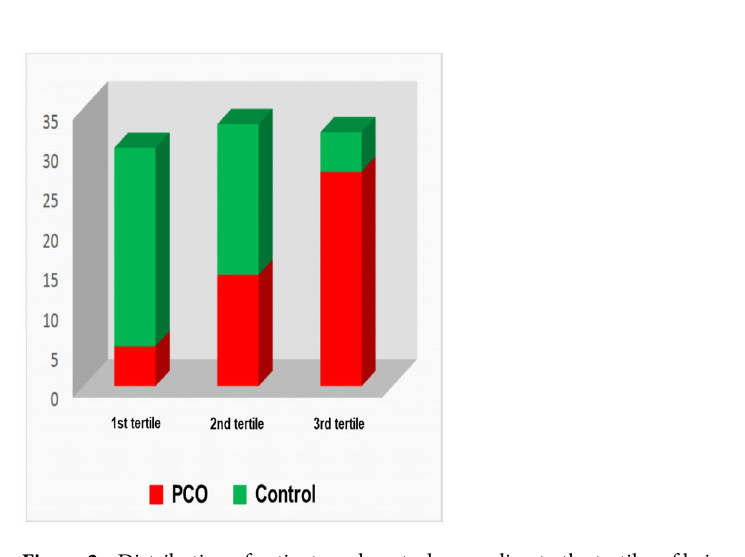
Figure 2. Distribution of patients and controls according to the tertiles of hair